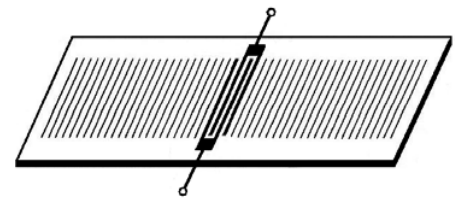
Figure 6. Scheme of a one-port SGAW resonator.